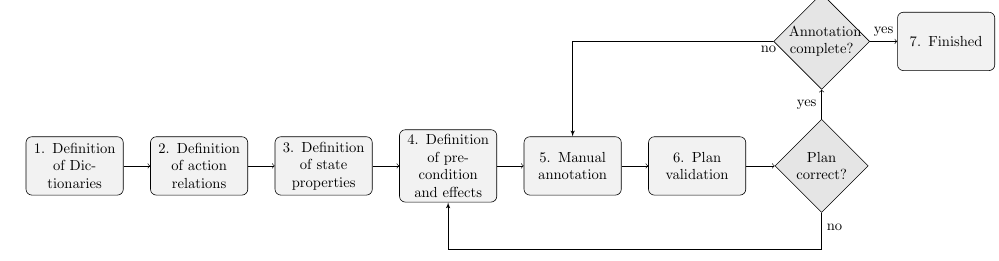
Figure 1. The proposed annotation workflow.